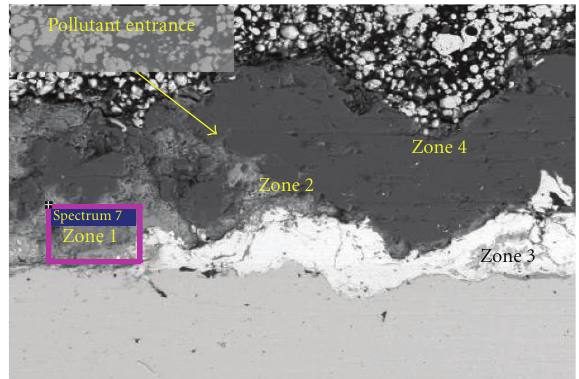
Figure 10: Thermal-sprayed Zn/Al double-layer, without sealer (thickness = 345 μ m). View in the SEM. Area near the incidence